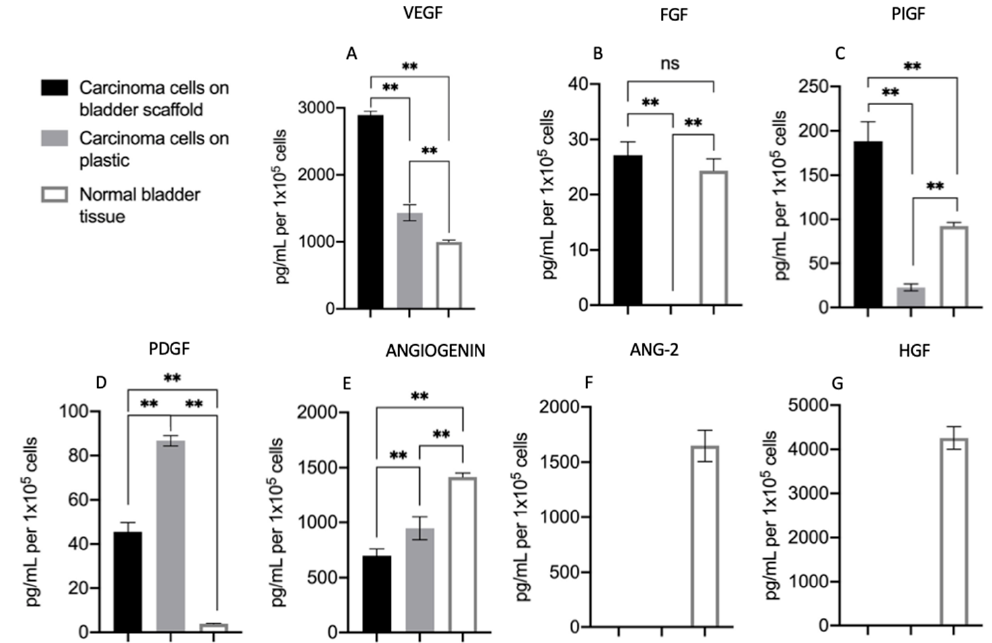
Figure 4. Different patterns of secreted growth factors of primary bladder carcinoma cells seeded on bladder scaffolds or on plastic, as well as of normal bladder tissue: ( A ) vascular endothelial growth factor (VEGF), ( B ) fibroblast growth factor (FGF), ( C ) placental growth factor (PIGF), ( D ) platelet-derived growth factor, ( E ) angiopoietin 2 (ANG-2), ( F ) angiogenin, and ( G ) hepatocyte growth factor (HGF). ** Statistically highly significant p ≤ 0.01; ns: no significant.